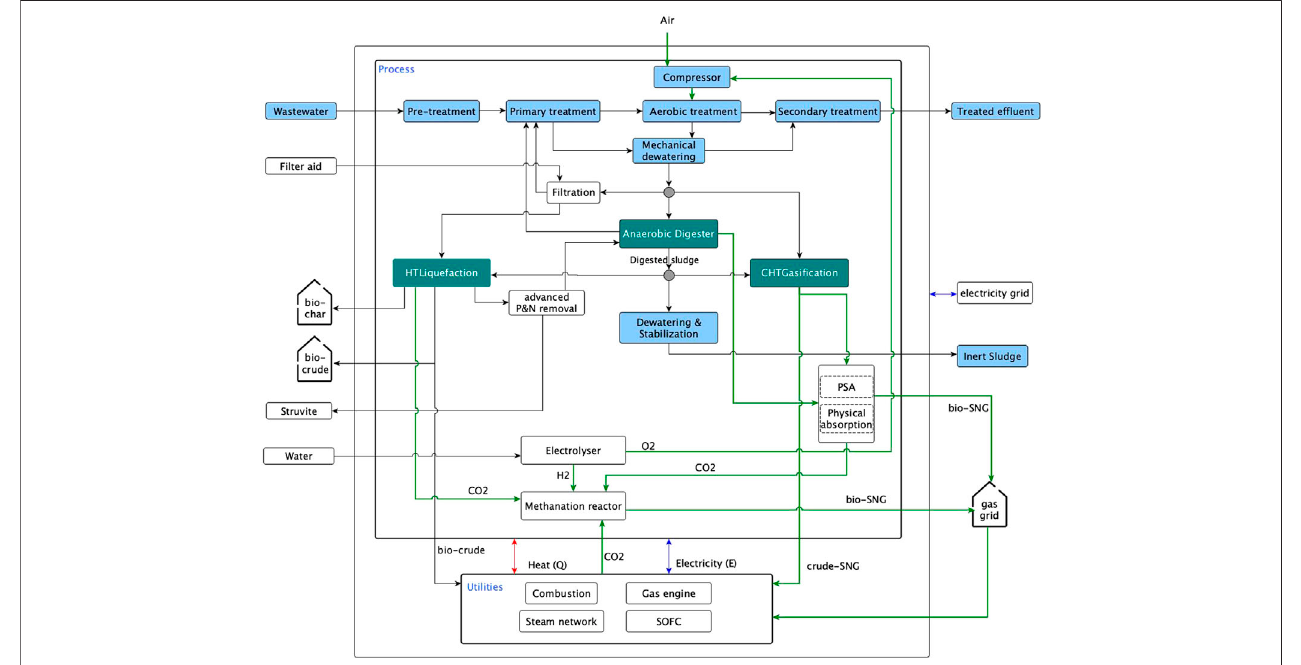
FIGURE 1 | Wastewater superstructure.